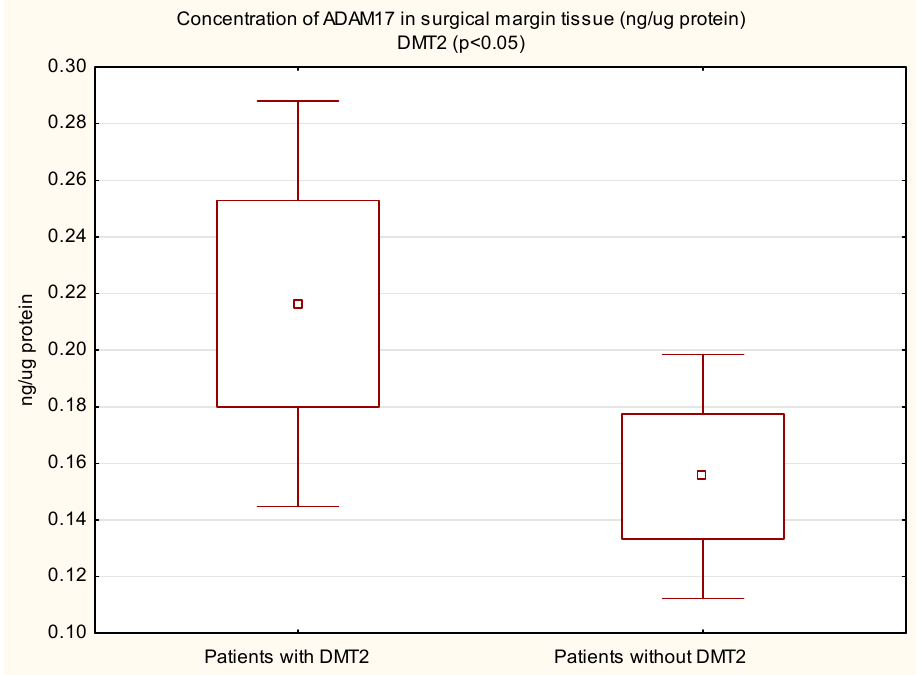
0 . Patients with DMT2 Patients without DMT2 Figure 2. Concentration of ADAM17 protein in margin tissue in CRC patients with and without Figure 2. Concentration of ADAM17 protein in margin tissue in CRC patients with and without coexisting DMT2. Figure 2. Concentration of ADAM17 protein in margin tissue in CRC patients with and without coexisting DMT2. coexisting